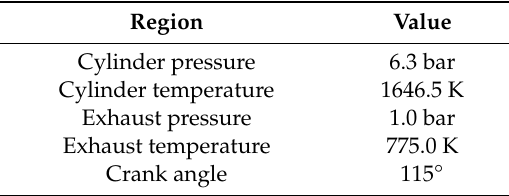
Table 3. Initial conditions of the 3D simulation.